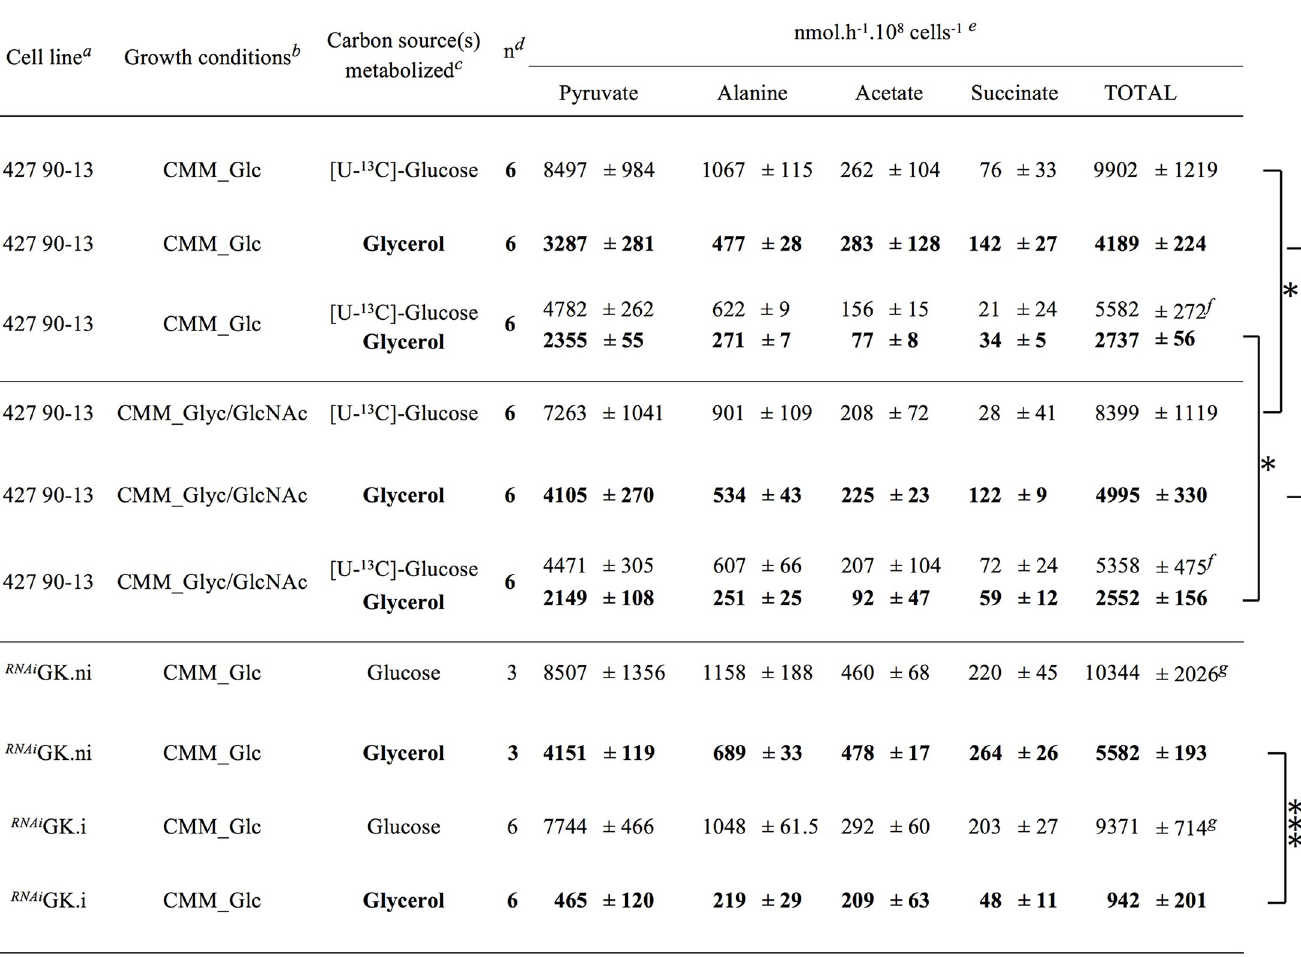
Fig 3. Excreted end products of glucose and glycerol metabolism by BSF parental and mutant cell lines. a .i: RNAi cell line induced during 5 days by addition of tetracycline; .ni: non-induced RNAi cell line. b The cells have been grown in CMM_Glc or CMM_Glyc/GlcNAc before incubation in PBS containing one or two carbon sources. c Carbon source(s) added in the incubation medium (PBS). d Number of biological replicates. e The amount of glycerol excreted from glucose metabolism is not estimated because of overlapping resonances between glucose and glycerol. f , g Data not significantly different with p-value � 0.05. � , �� , ��� Data significantly different with p-value � 0.05, � 0.01 and � 0.001,